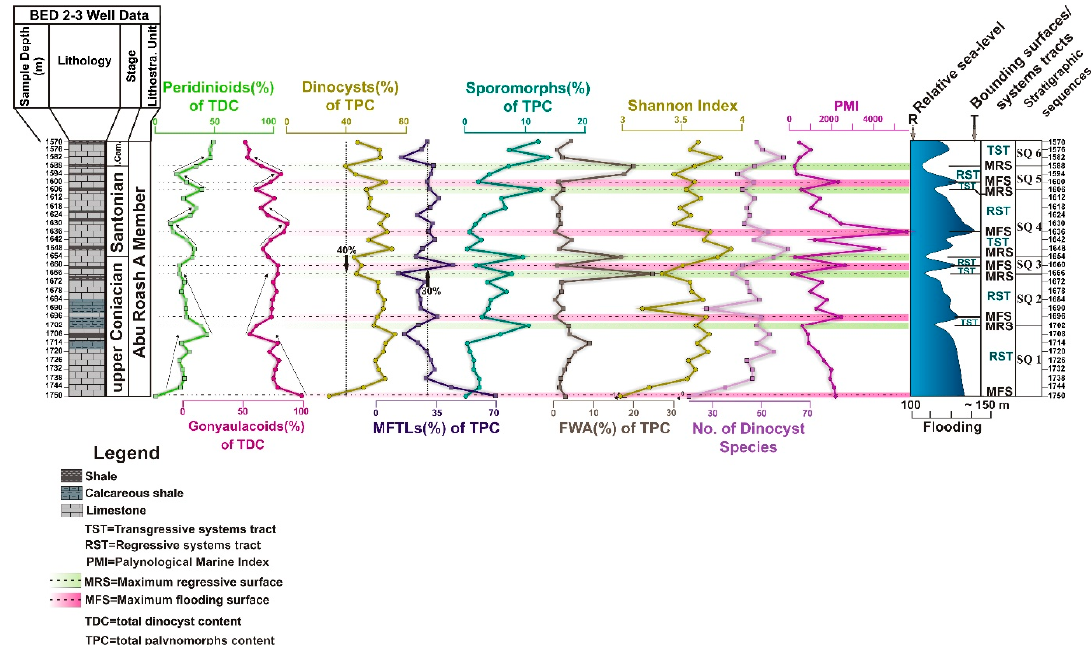
Figure 4. Stratigraphic vertical distribution of various palynomorphs components and dinocyst diversity used to construct transgressive-regressive trends of the relative sea level as well as the stratigraphic sequences and systems tracts of the Abu Roash A Member.